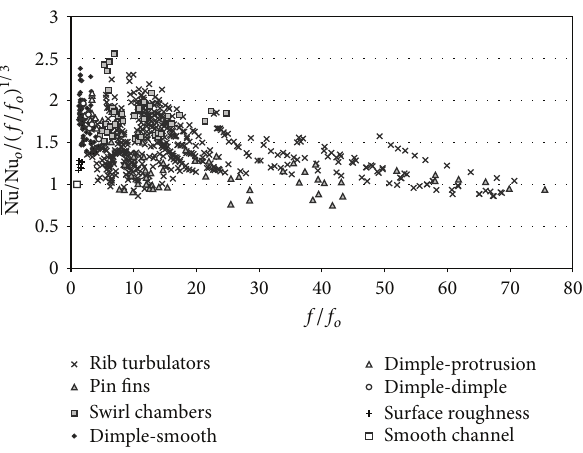
Figure 4: Comparison of relative performance of rib turbulators, pin fins, swirl chambers, dimple-smooth arrangements, dimple- protrusion arrangements, dimple-dimple arrangements, surface roughness, and smooth-walled channels from investigations prior to 2003. Globally averaged thermal performance parameters Nu / Nu 𝑜 /(𝑓/𝑓 𝑜 ) 1/3 are presented as dependent upon friction factor ratios 𝑓/𝑓 𝑜 [1].